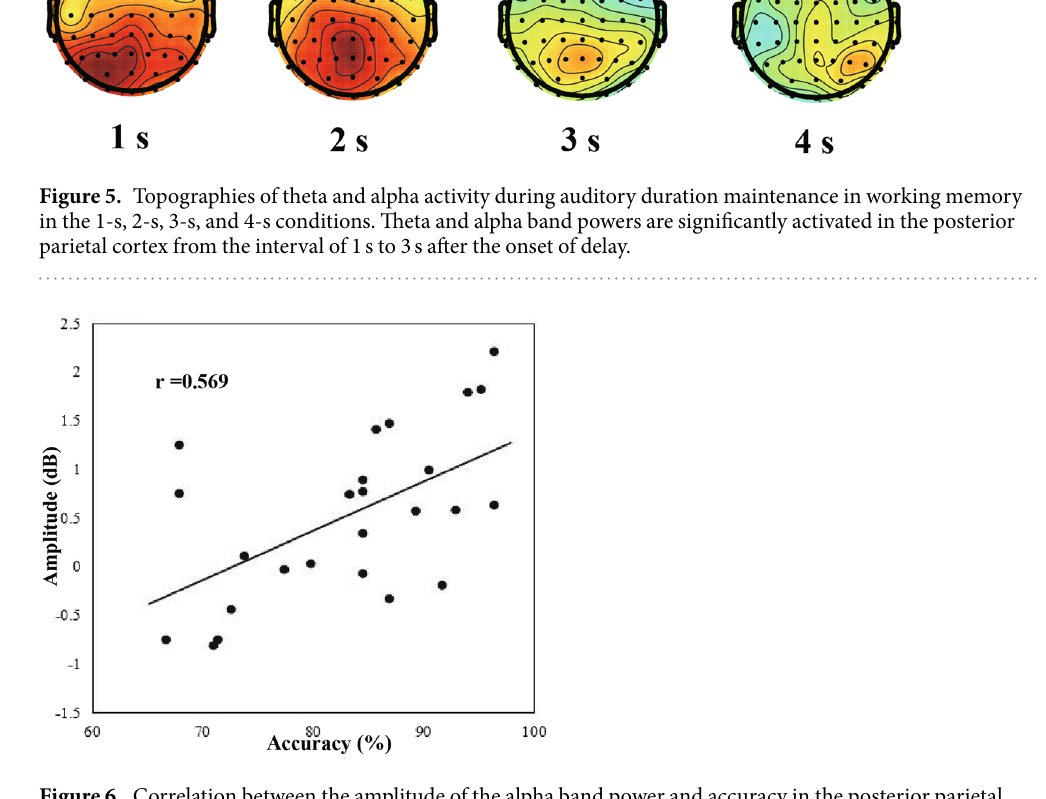
Figure 6. Correlation between the amplitude of the alpha band power and accuracy in the posterior parietal during the 2-s auditory duration condition. The scatter plot depicts the amplitude of the alpha power (y - axis) relative to the accuracy of the behavioural performance (x-axis) in the 2-s auditory duration condition. Pearson product-moment correlation coefficient, r =